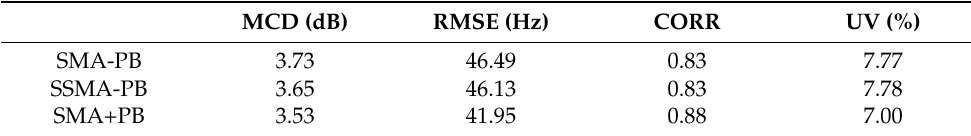
Table 1. Objective performance of SMA-PB, SSMA-PB, and SMA+PB on predicting the acoustic features of test sentences, where MCD , RMSE , CORR , and UV denote the mel-cepstral distortion, F0 root mean square error, F0 correlation, and UV error percentage, respectively.